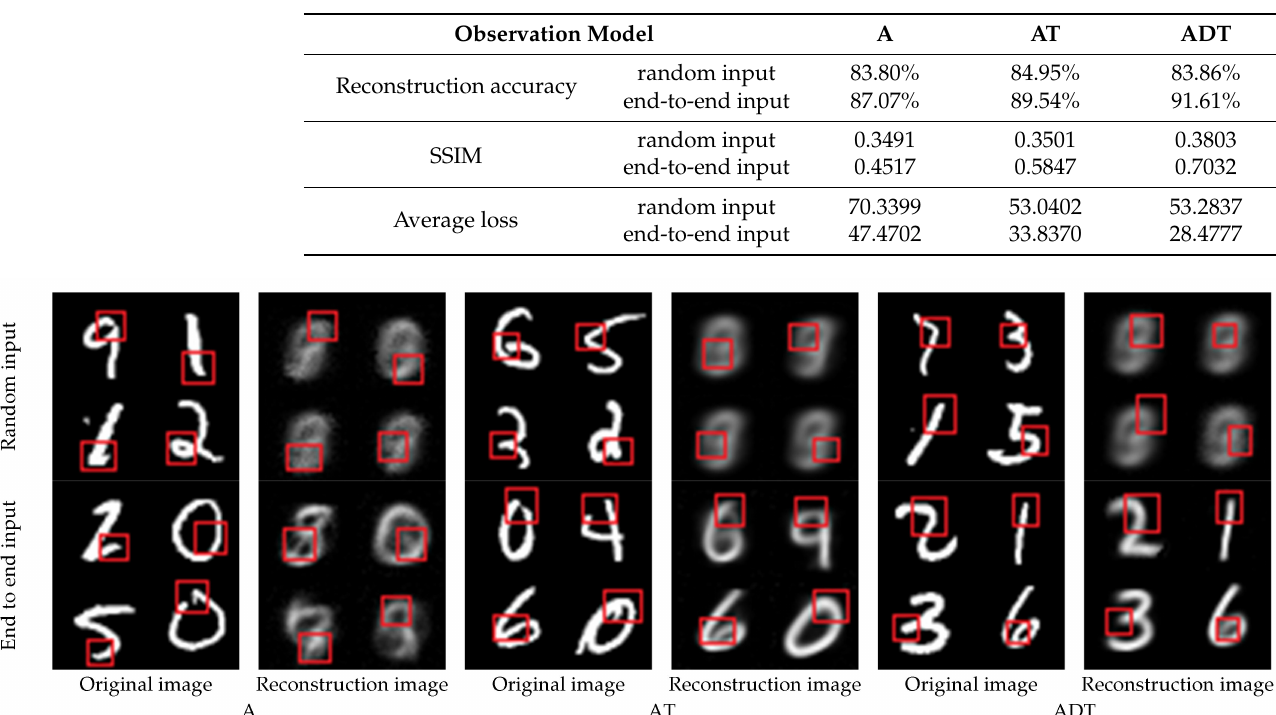
Table 8. Comparison of reconstruction results for extreme observations.